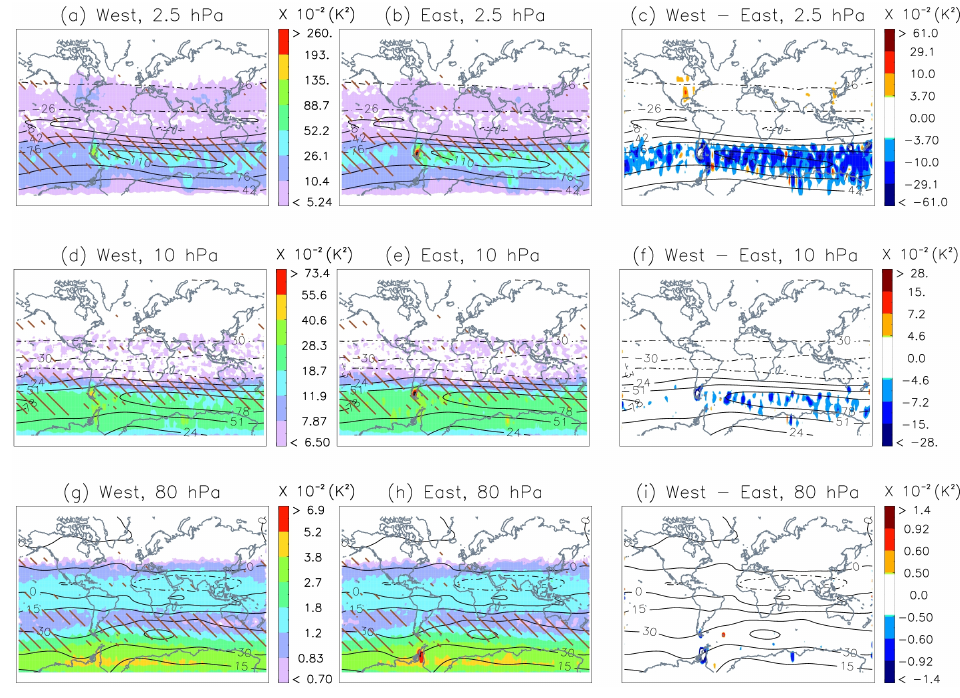
Fig. 6. Same as Fig. 5, except for July 2005.